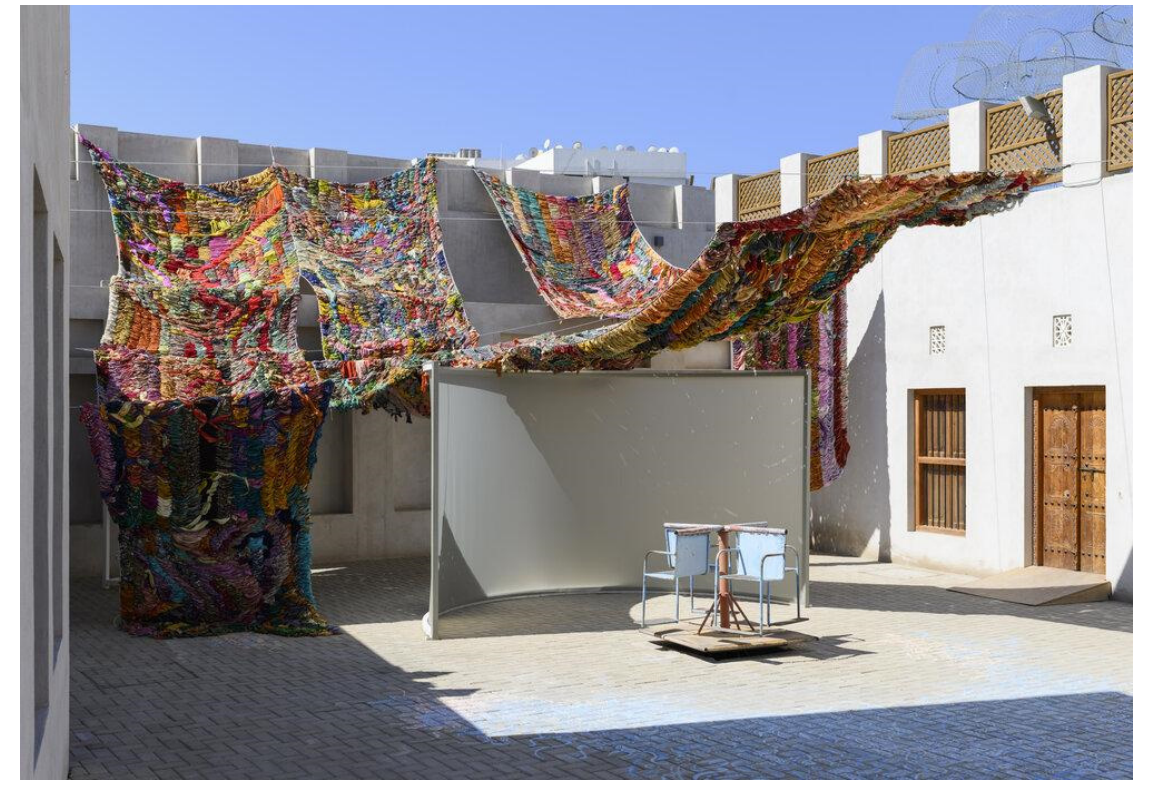
Figure 7. Suchitra Mattai, Imperfect Isometry , 2019, vintage sari tapestry (Sharjah Biennial).